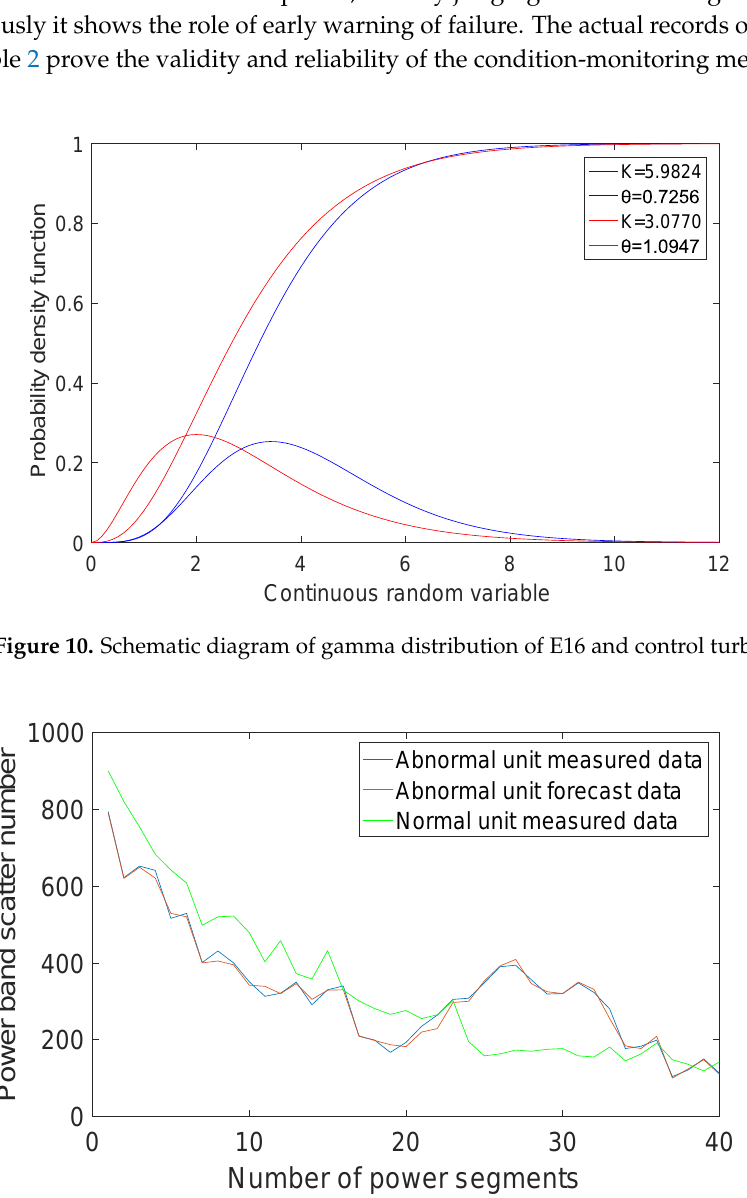
Figure 11. Comparison of convolutional neural network model prediction data and measured